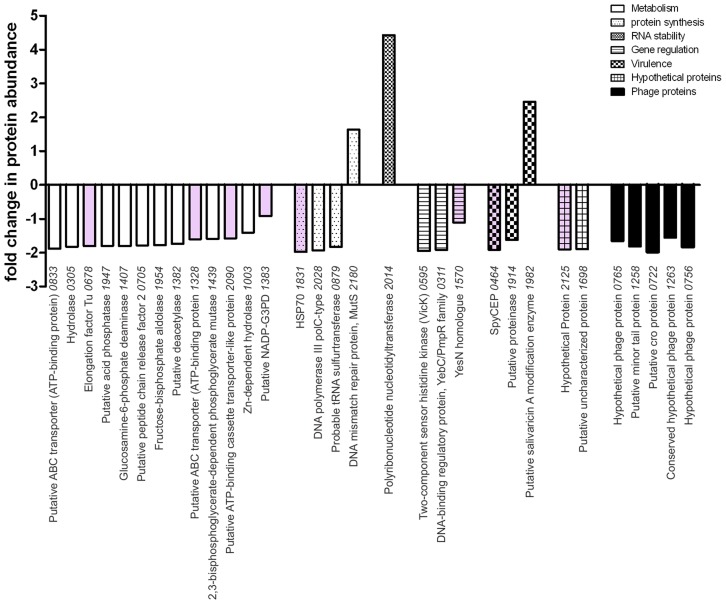
RocA has targeted impact on GAS proteome that is distinct from the CovR/S regulon.The impact of expressing full-length RocAM89 on the GAS-M18 proteome was ascertained by quantitative SDS-PAGE LC-MS/MS using cell pellets obtained from 4 independent cultures of isogenic strains GAS-M18 and GAS-M18rocAM89. Values represent relative protein abundance (fold-change) in strain GAS-M18rocAM89 relative to parent strain GAS-M18. Pink shading highlights genes included in the CovR/S regulon. Only proteins with altered expression of >1.5 fold and p≤0.05 were included. Numbers on x-axis represent M18 strain MGAS8232 ORFs.